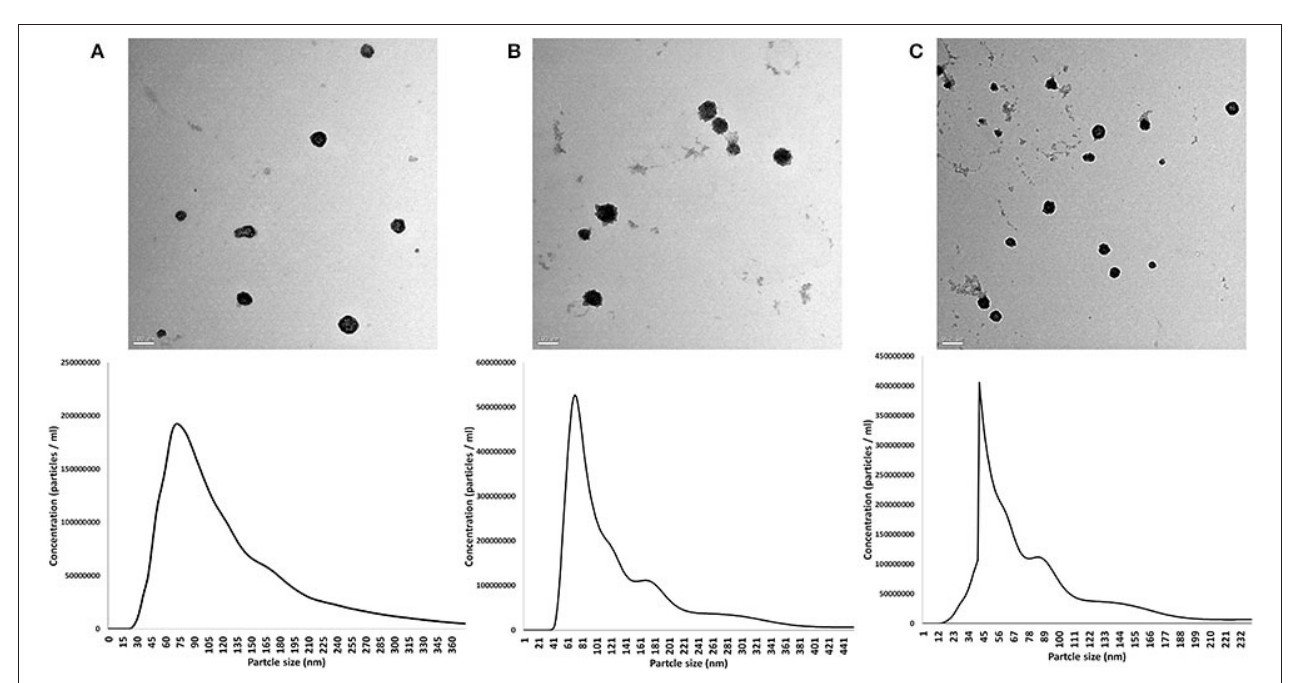
FIGURE 1 | Primary culture of prostate, testis, and epididymis tissues. Asterisk indicates the tissue explants. Outgrowths and cell monolayers were maintained until the 14th day of culture. Scale bar , 500 µ m.